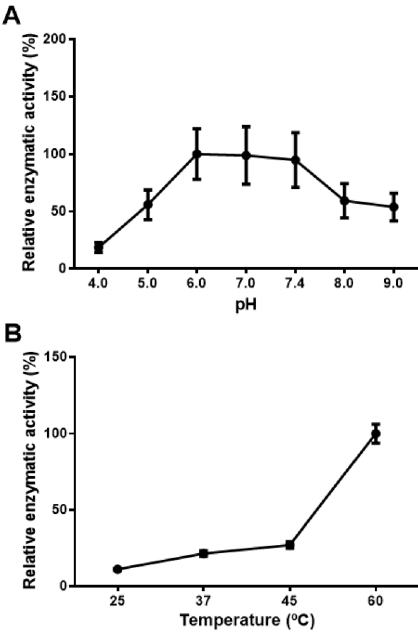
Figure 3. Effect of pH ( A ) and temperature ( B ) on adenosine deaminase (ADA) activity in human lymphocyte-rich peripheral blood mononuclear cells. After incubation, ADA activity was assayed under standard conditions. The data are reported as means ± SE.